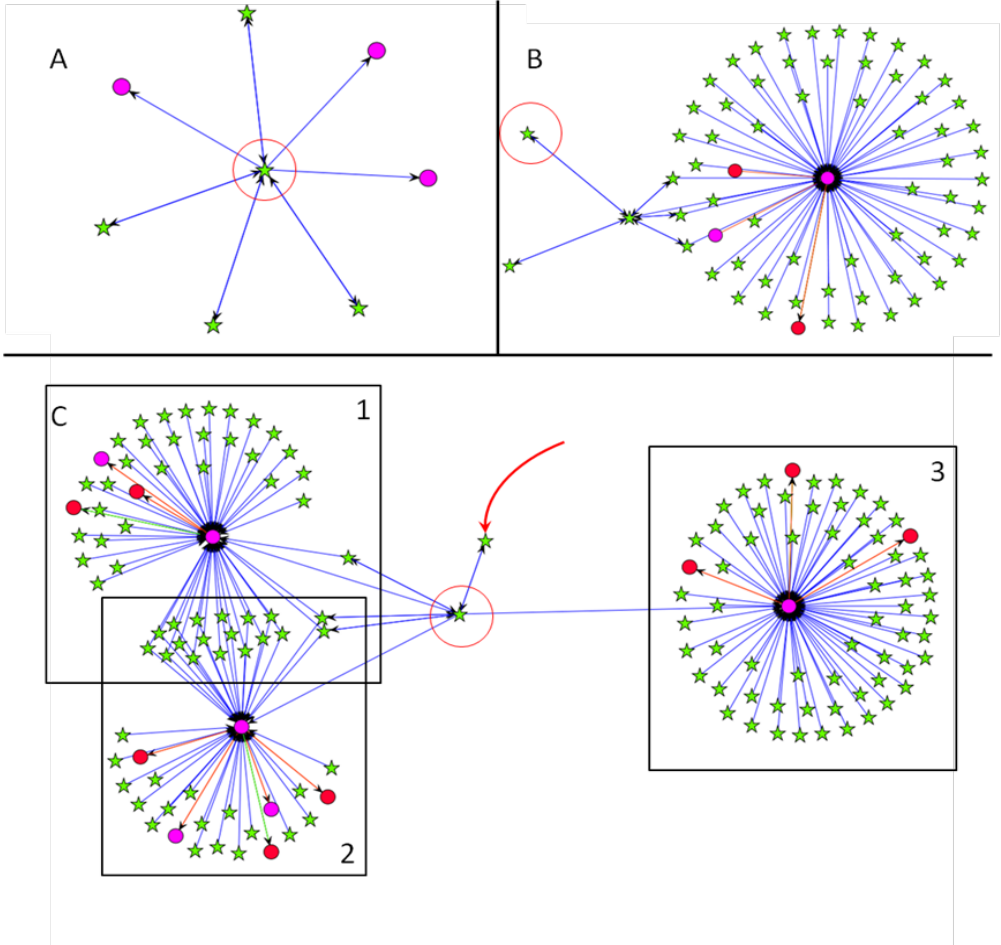
Figure 3: Chlorpromazine is circled in red in all panels. A – First neighbours of chlorpromazine in the Ondex graph. B – First neighbours of trimeprazine and its protein target, histamine H1 receptor. C – First neighbours of chlorpromazine and the protein targets to which it binds. D(2) Dopamine receptor (group 1), 5-hydroxytryptamine 2A receptor (group 2) and Serum Albumin (group 3). The red arrow indicates trimeprazine, which is not involved in the same groups of interactions as the other neighbours of chlorpromazine. Ondex colour scheme – drugs are represented by green stars, targets are pink circles and proteins are red